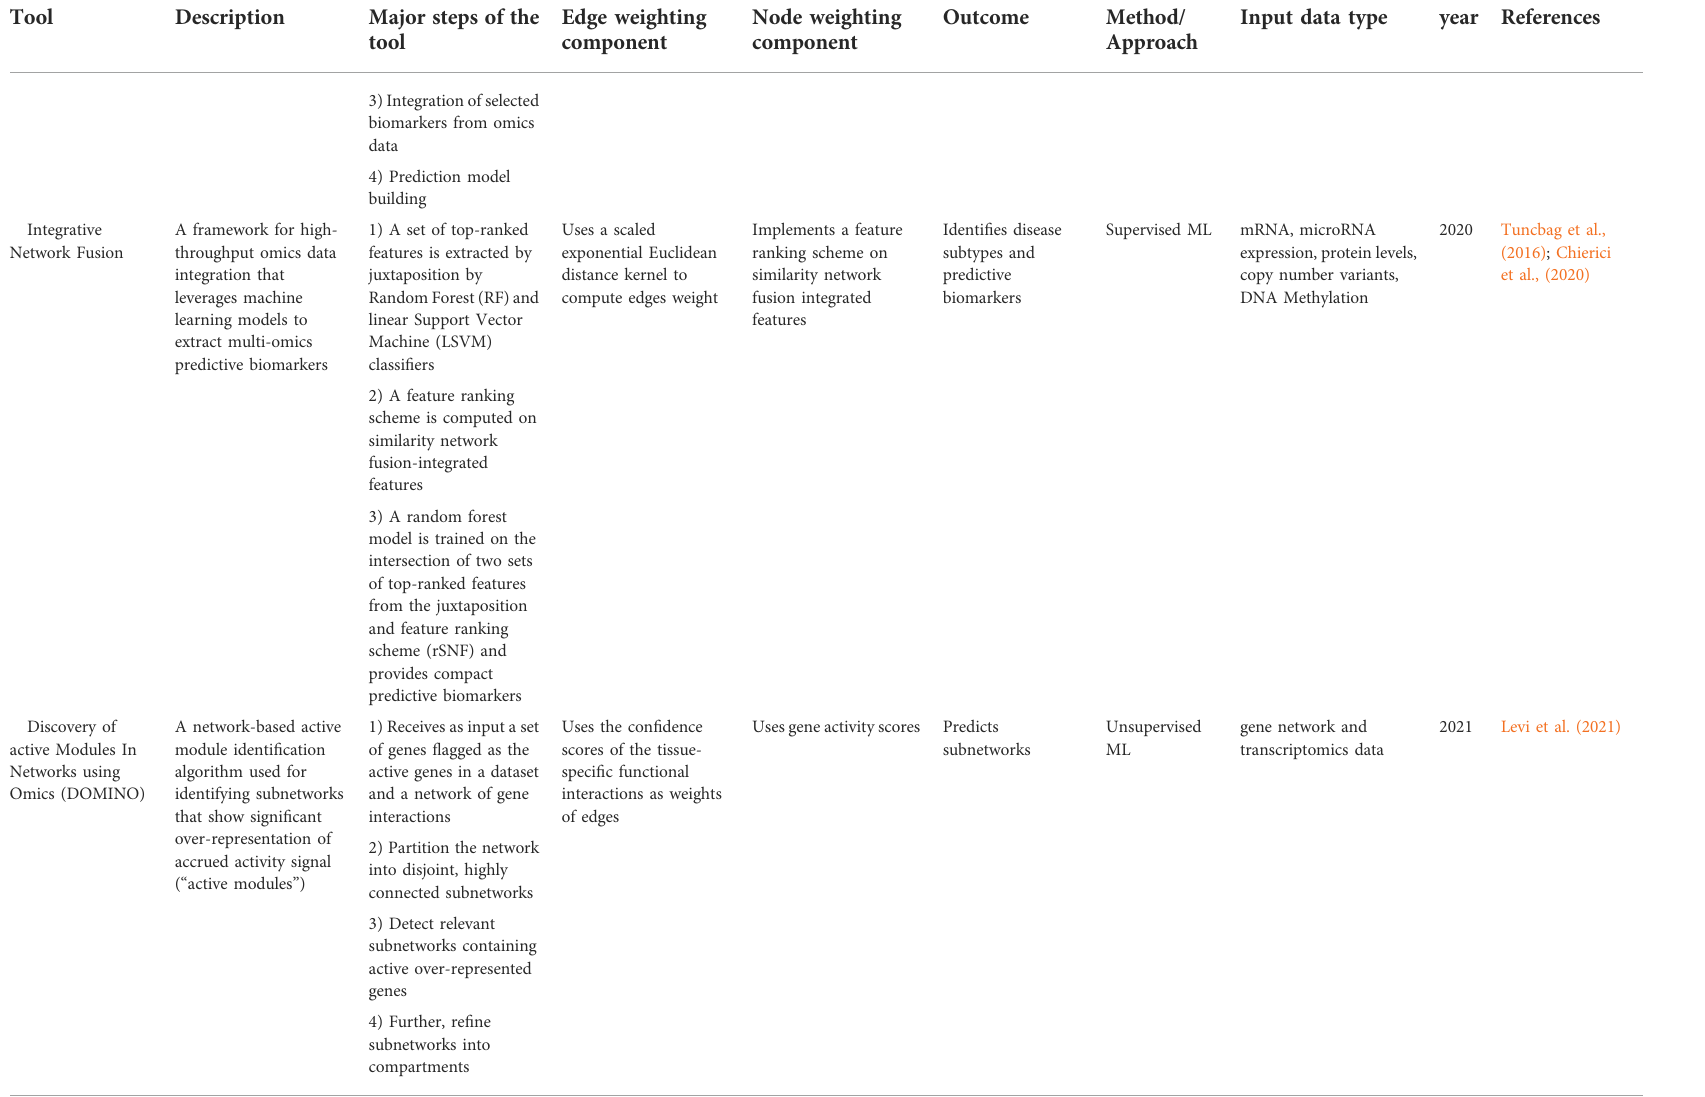
TABLE 1 ( Continued ) Network-based multi-omics integrative tools for predicting biomarkers, crosstalk, disease subtypes, and subnetworks/enriched